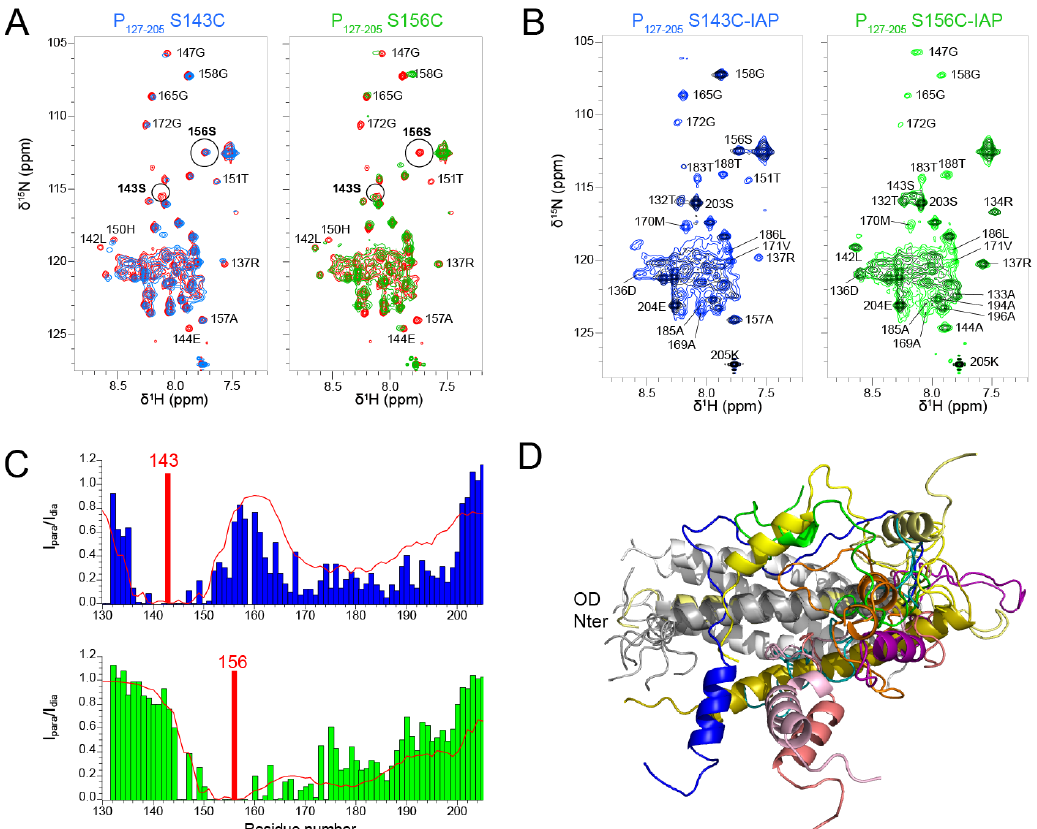
Figure 6. Spatial sampling of the C-terminal P C α region proximal to the oligomerization domain of RSV P by Paramagnetic Relaxation Enhancement experiments. ( A ) Comparison between 1 H- 15 N HSQC spectra of WT P 127–205 (red) and P 127–205 mutants S143C (blue) and S156C (green). NMR spectra were acquired at 600 MHz 1 H frequency and a temperature of 313 K. Assignments of several isolated signals are indicated. ( B ) 1 H- 15 N HSQC spectra of IAP-labeled P 127–205 S143C and S156C mutants in paramagnetic (black) and diamagnetic states (S143C in blue, S156C in green). ( C ) Paramagnetic relaxation enhancements (PRE), determined as intensity ratios I para /I dia for each residue, are plotted as bar diagrams. The position of the IAP spin labels is indicated by a red bar. Theoretical PREs, plotted as a red line, were calculated with the Flexible-meccano software [50] from an ensemble of 1000 P 127–205 structures, using a contact distance of 7 Å between P OD residues 143–156 and P C α residues 160–199. ( D ) 10 randomly chosen P 127–205 conformers were aligned onto the P OD structure to exemplify the transient structure of P C α and the transient contacts between the P C α helices and P OD